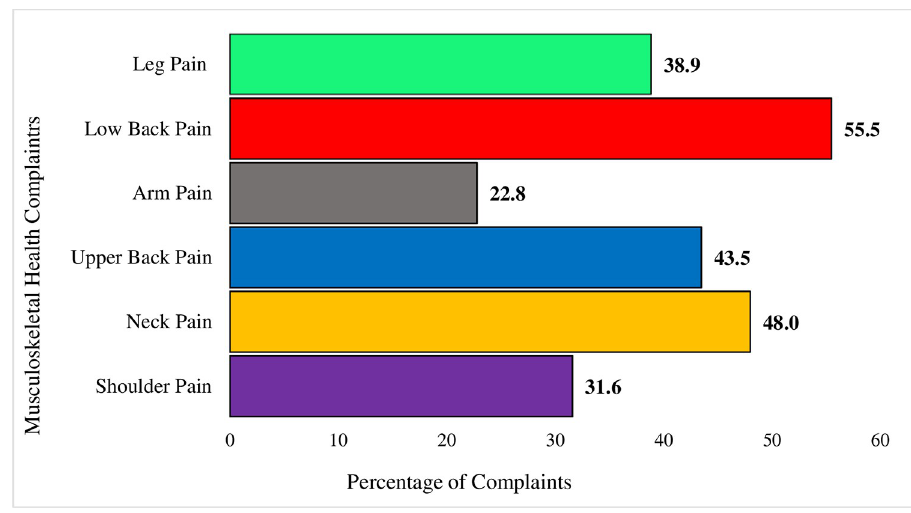
Fig 1. Prevalence of musculoskeletal health complaints among sedentary, monotonous urban workers.